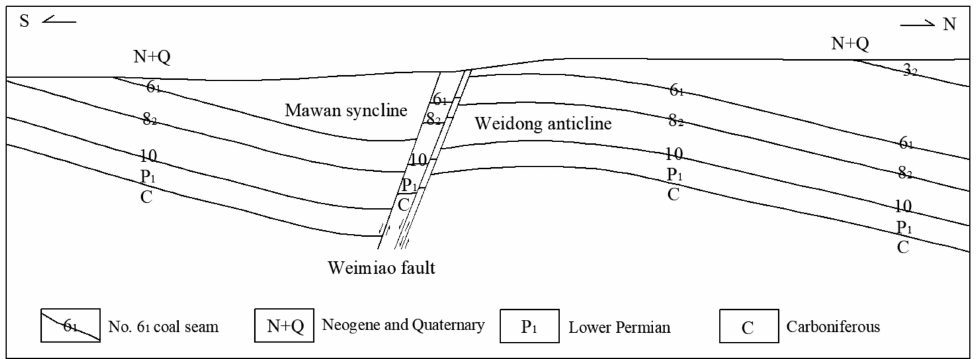
Figure 6. Geological section of no. 24 exploration line at the Qidong coal mine. Simplified from